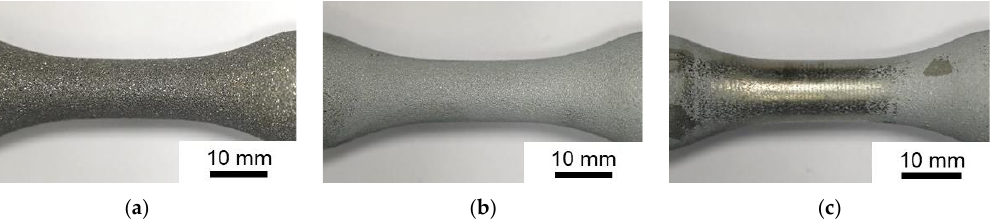
Figure 3. Gauge length of specimen conditions I – III: ( a ) sandblasted (I), ( b ) ZnAl-coated (II), ( c ) MHP post-treated (III).